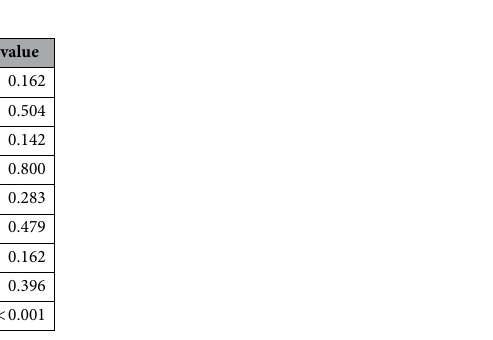
Figure 4. Scatter plots showing the association between RHI value and the number of rehospitalization RHI, reactive hyperemia index.